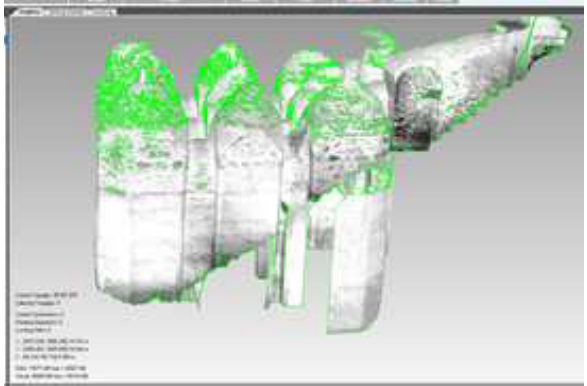
Figure 9-a. 25% filtered point cloud and medium smoothed mesh